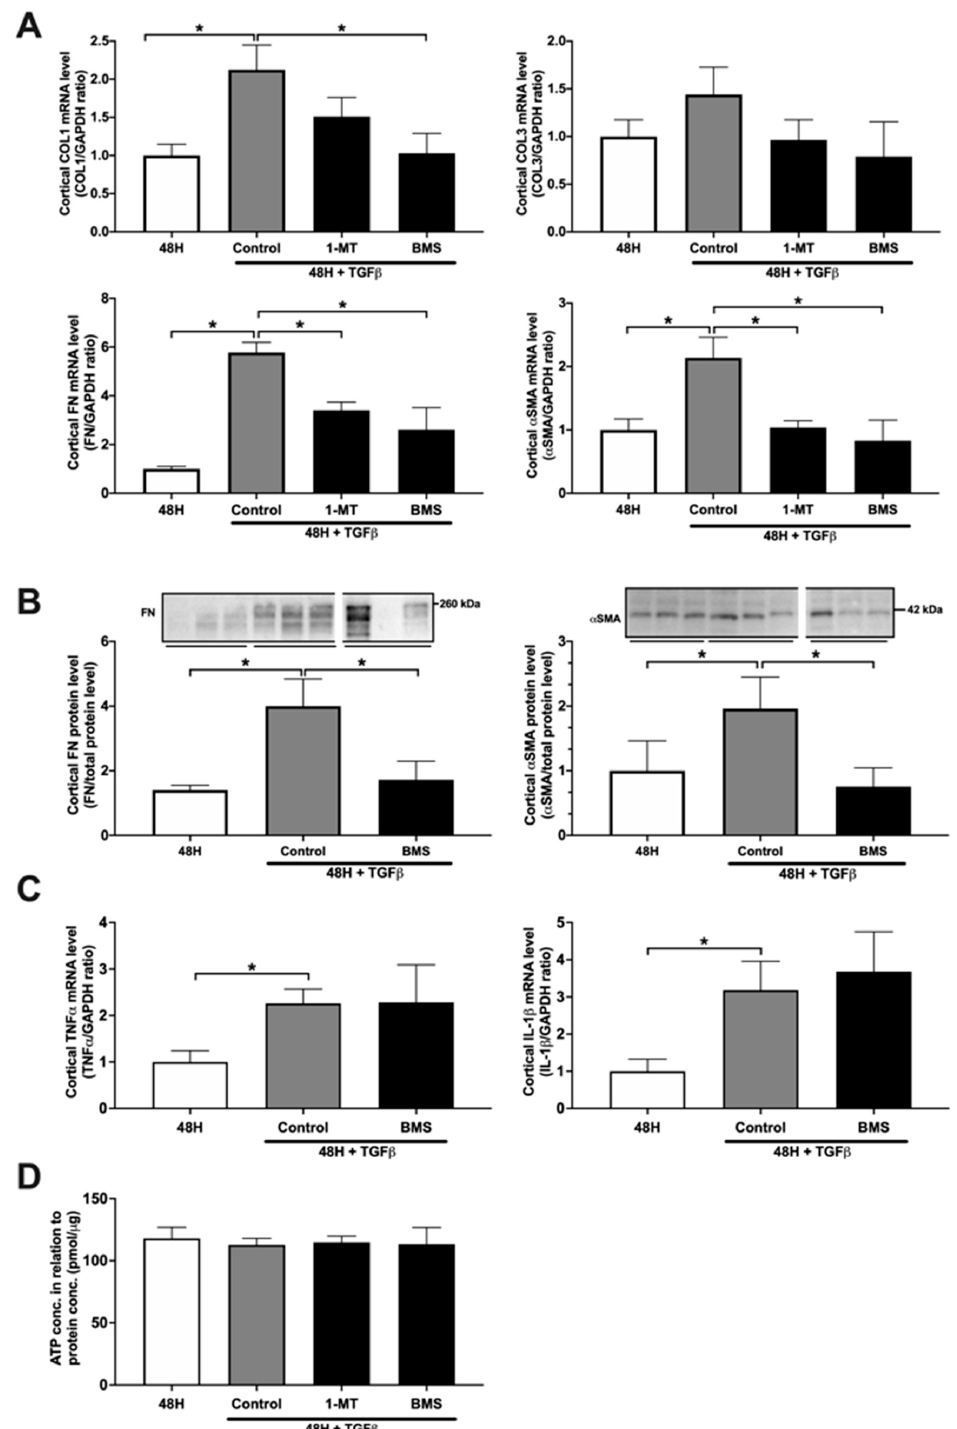
Figure 1. 1-methyl-D-tryptophan and BMS-986205 mitigate TGF- β -induced fibrosis in murine PCKS. PCKS were exposed to 10 ng/mL TGF- β in the absence or presence of 1-methyl-D-tryptophan (1 mM; 1-MT) or BMS-986205 (5 nM) for 48 h. ( A ) Relative mRNA expression of the fibrosis markers collagen 1A1 (COL1), collagen 3A1 (COL3), fibronectin (FN), and α -smooth muscle actin ( α SMA) normalized to GAPDH. n = 4–10. ( B ) Western blotting was used to study the protein expression of fibronectin (FN) and α -smooth muscle actin ( α SMA). n = 7. ( C ) Relative mRNA expression of the inflammation markers tumor necrosis factor alpha (TNF α ) and interleukin 1 beta (IL-1 β ) normalized to GAPDH. n = 6–7. ( D ) Viability of mPCKS after treatment, assessed by ATP content of the slices. n = 4–10. Data are presented as mean ± SEM. * p <